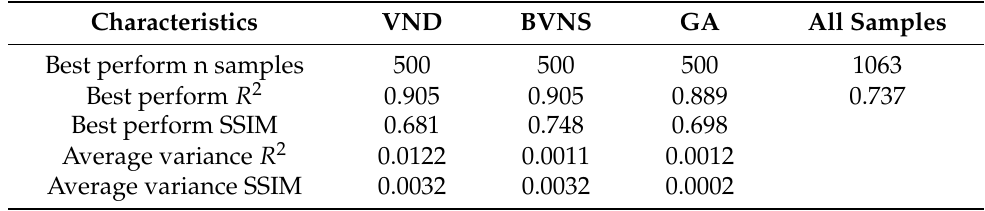
Table 2. Best and average values of statistical characteristics for the considered algorithms obtained by the parameter search. BVNS shows the best accuracy for R 2 and SSIM and has the smallest variance for R 2 . All the algorithms show their best performance on 500 training samples. (see Appendix A for the final set of best parameter